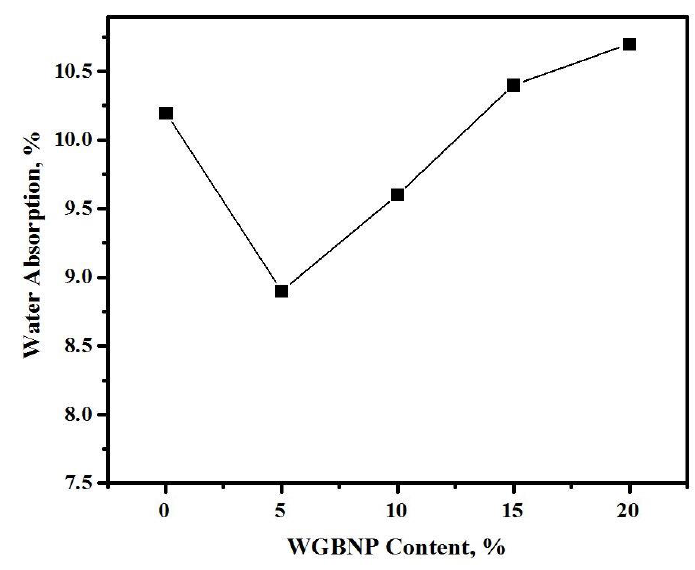
Figure 11 . Water absorption of AAMs containing various ratios of BGWNP at 28 days .